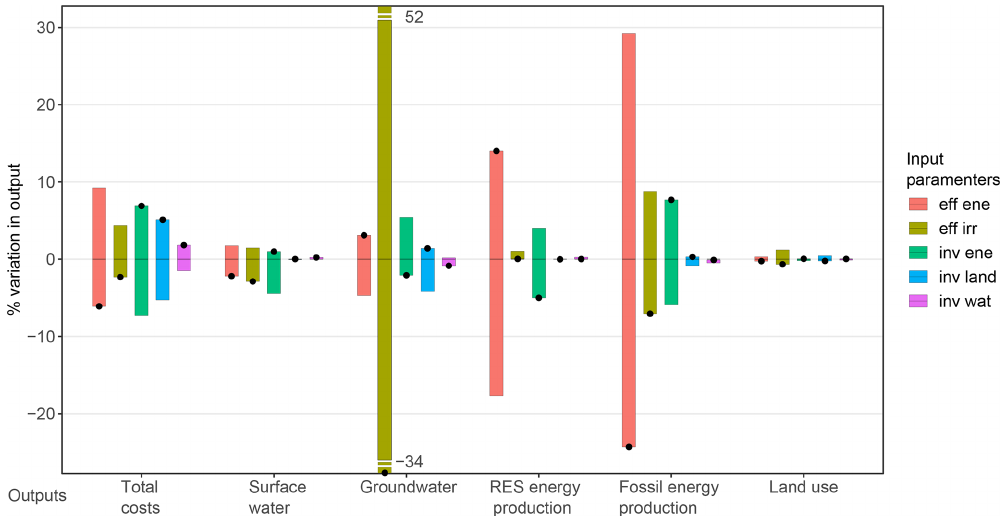
Figure 14. Changes in model outputs in response to a variation ( − 25%, + 25%) of input parameters, namely power plants’ efficiency (eff ene), irrigation technologies’ efficiency (eff irr), investment costs of power plants and transmission lines (inv ene), irrigation and land management (inv land) and water distribution/treatment (inv wat). The outputs refer to average yearly values for basin’s total system costs, surface and groundwater withdrawals, energy production from renewable or non-renewable sources and land use for agriculture. The black dots show the outputs corresponding to + 25% variation in